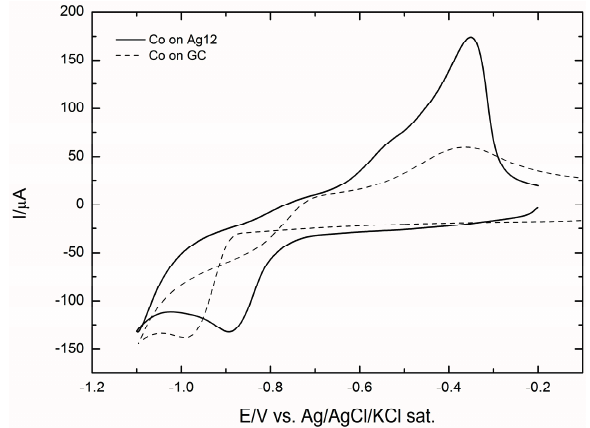
Figure 6. Cyclic voltammograms of Co(II) solution (5 × 10 − 3 M) recorded at the GC electrode (dashed curve) and at the GC/Ag12 mC electrode (solid line).